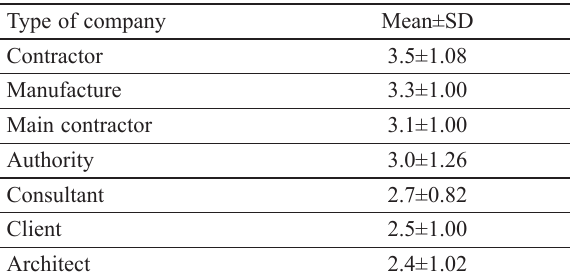
Table 6. Mean score and Standard Deviation of “ B1.1: value equals the price of the building ” for the different types of companies